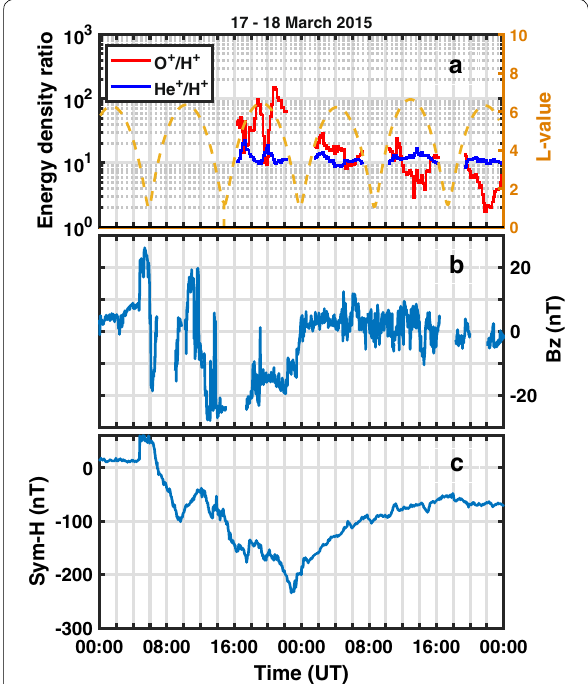
Fig. 3 a Energy density for O + /H + (red) and He + /H + (blue) for 17–18 March 2015 is shown using RBSP-A, b IMF Bz, c Sym-H